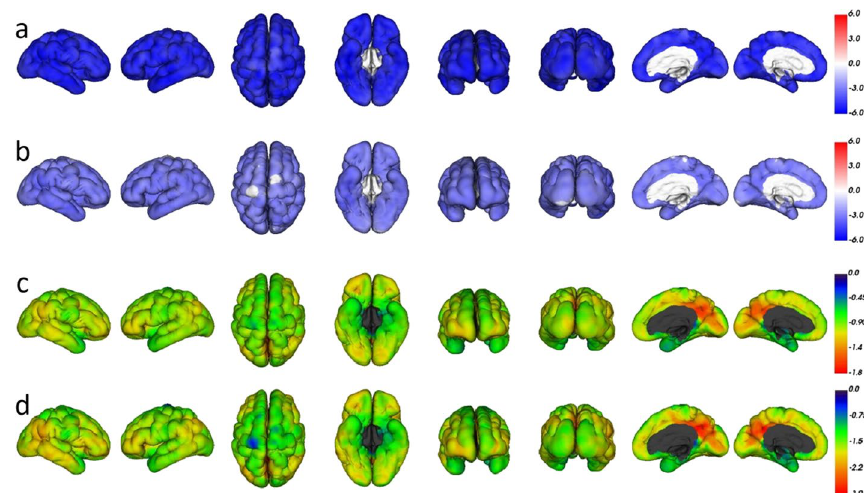
Table 6 Mixed-effects model of precuneus against whole brain, including two-way interactions